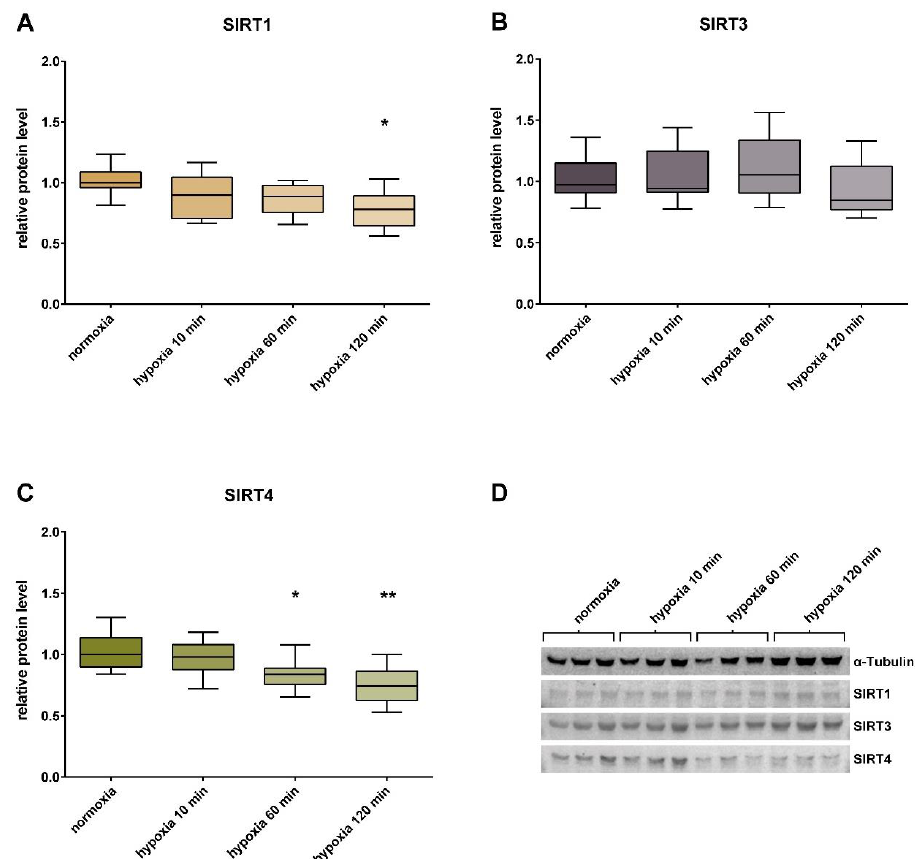
Figure 2. Western blot analysis and relative protein content of sirtuins in HUVECs. The relative protein content of SIRT1 ( A ), SIRT3 ( B ), and SIRT4 ( C ) in HUVECs. Controls under the normoxic conditions were compared with cells incubated under hypoxia for 10, 60, and 120 min. Shown are the median, upper, and lower quartile, and the 5% and 95% percentile. Each group had a sample size of n = 3. Significance: * p < 0.05 and ** p < 0.005. Representative Western blot analysis ( D ) of cells incubated under normoxia (21% O 2 ) and hypoxia (2% O 2 ) for 10, 60, and 120 min. α-Tubulin ~52kDa; SIRT1 ~110 kDa; SIRT3 ~44 kDa; SIRT4 ~39 kDa. J. Clin. Med. 2020 , 9 , x FOR PEER REVIEW Sirtuin capacity levels (in vitro activity under substrate saturation and optimal pH) tended to decrease during short-term hypoxia treatment, but without a significant difference (Figure 3). Basal SIRT1 enzyme capacity (corresponding to 1.0) averaged 1.8 U/10,000 cells in the normoxic HUVECs. The basal enzyme activity of SIRT3 averaged 9.5 U/µg protein.